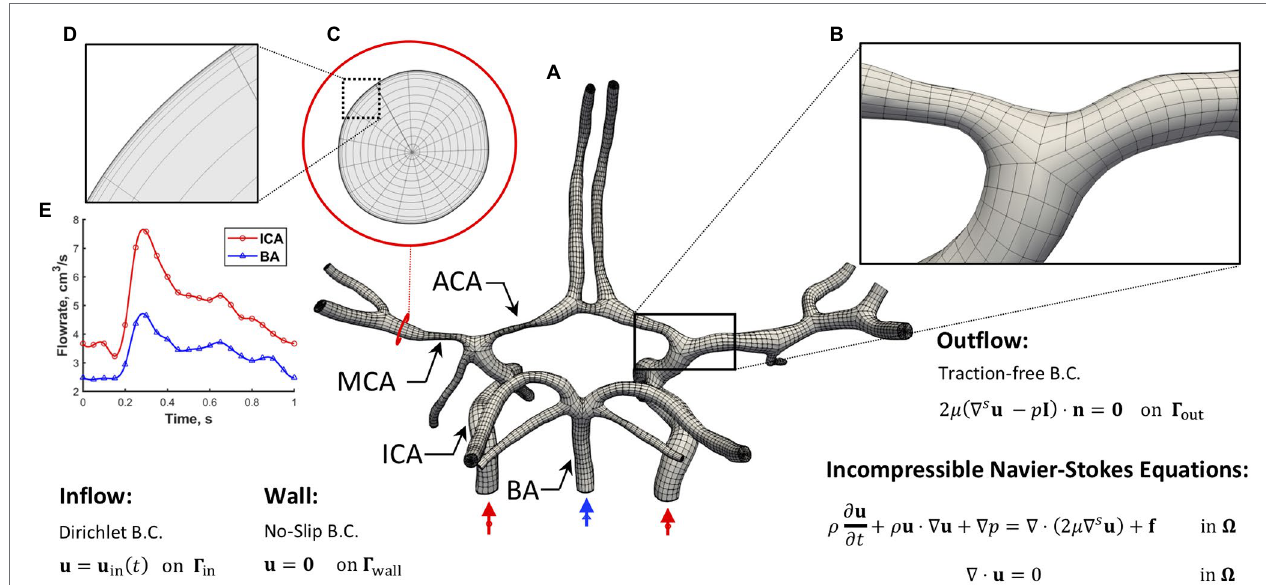
FIGURE 1 | Simulation setup. (A) The hexahedral NURBS mesh of a human CoW with a bifurcation (B) is shown. A cross-section of the computational mesh (C) is shown to highlight the boundary layer refinement (D) we implemented. The governing equations subjected to boundary conditions (B.C.s) are also presented, where u represents velocity, p is the pressure, f is the external force, μ is dynamic viscosity, ρ is density, t is time, and n is the unit normal. (E) A pulsatile inflow condition is prescribed at the three inlets. Left and right ICAs (red waveform) and BA (blue waveform). A no-slip B.C. is imposed on the vessel wall, and a traction-free B.C. is set at all the outlets.